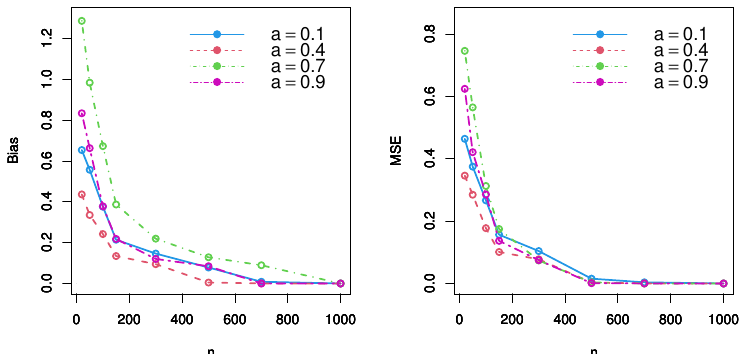
Figure 3. Simulation results for DWPLT parameters using the MLE method.